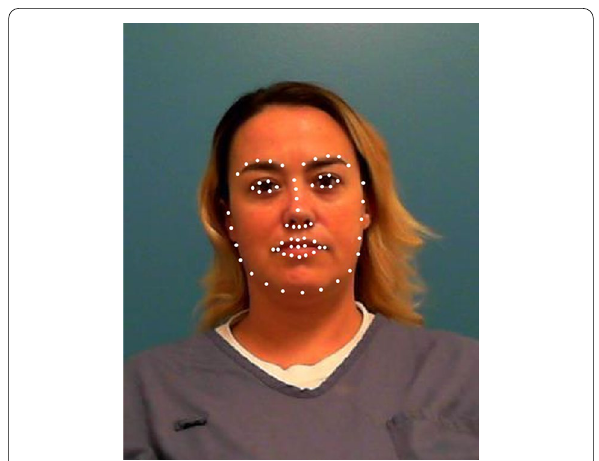
Fig. 1 One face with their facial landmarks overlayed on their face in white dots. The x - and y -coordinates of the face as used in the MDS solution, along with: their actual age, their predicted age, numbers corresponding to the prediction of how likely the face belongs to each of the following races (i.e., Asian, Indian, Black, White, Middle Eastern, and Hispanic). Note : the actual landmarks have been increased from their pixel-length diameter for viewing purposes. There are 68 points but some of the points overlap, giving the appearance of only 64